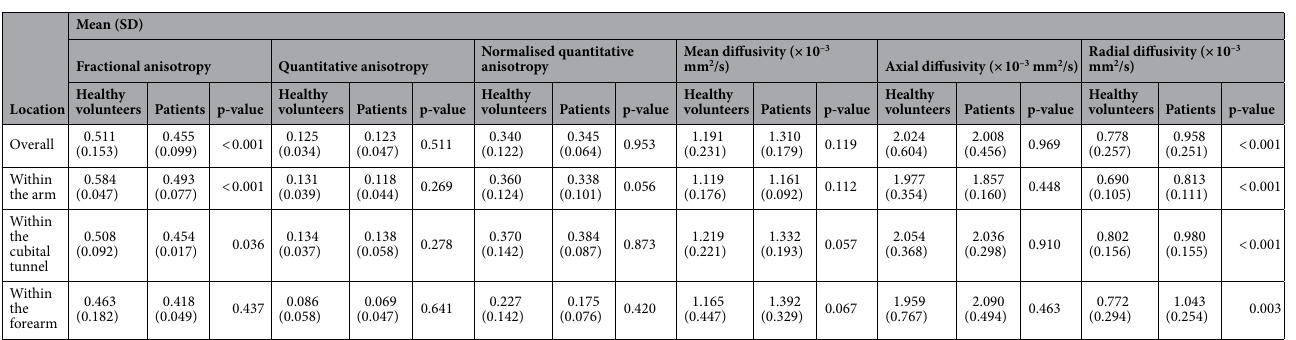
Table 2. Diffusion tensor imaging (DTI) and generalised q-space imaging (GQI) metrics from the ulnar